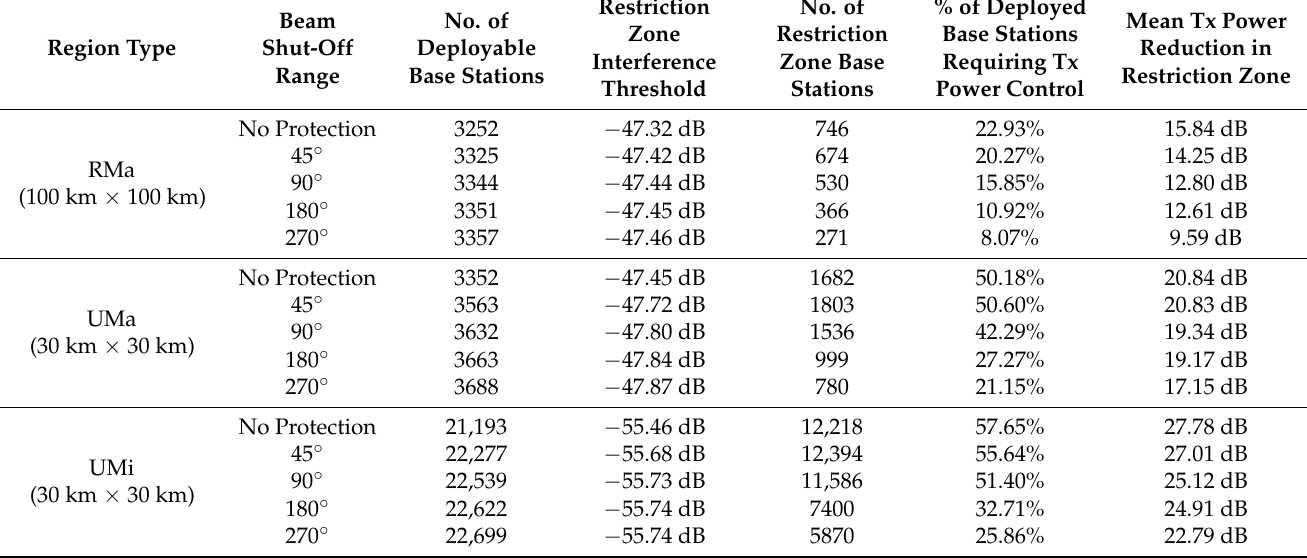
Table 4. Mean transmission (Tx) power reduction in the restriction zone for RMa, UMa, and UMi using an 8 × 8 antenna